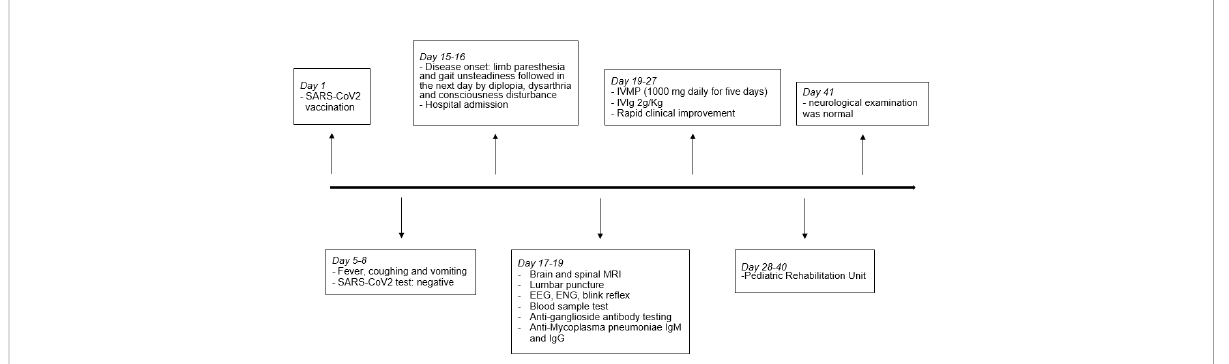
FIGURE 2 Timeline with selected events. EEG, electroencephalogram; ENG, electroneurography; IVIg, intravenous immunoglobulin; IVMP, intravenous methylprednisolone; MRI, magnetic resonance